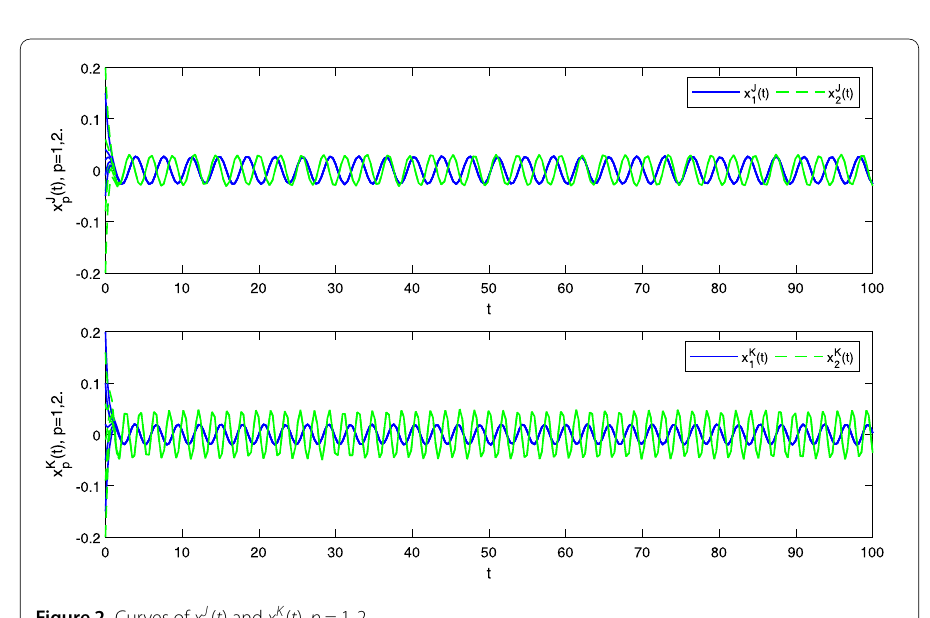
Figure 2 Curves of x J p ( t ) and x K p ( t ), p =